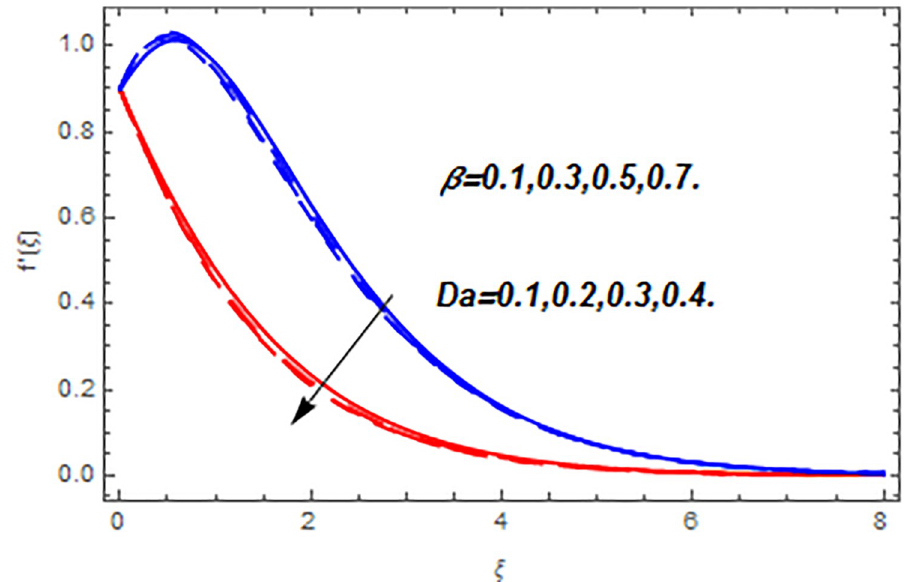
Fig 3. Flow profiles versus Darcy number and Casson